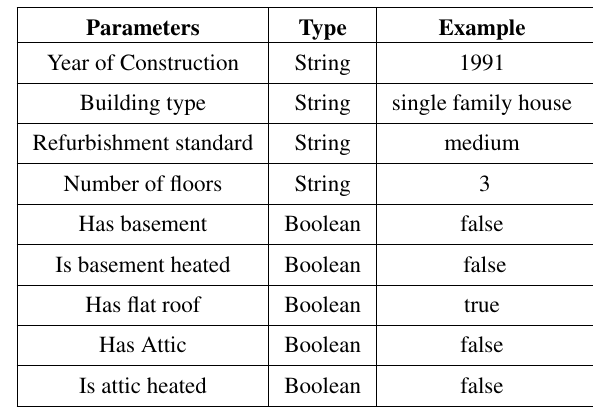
Table 1. The input parameters required for the SimStadt heat demand simulation